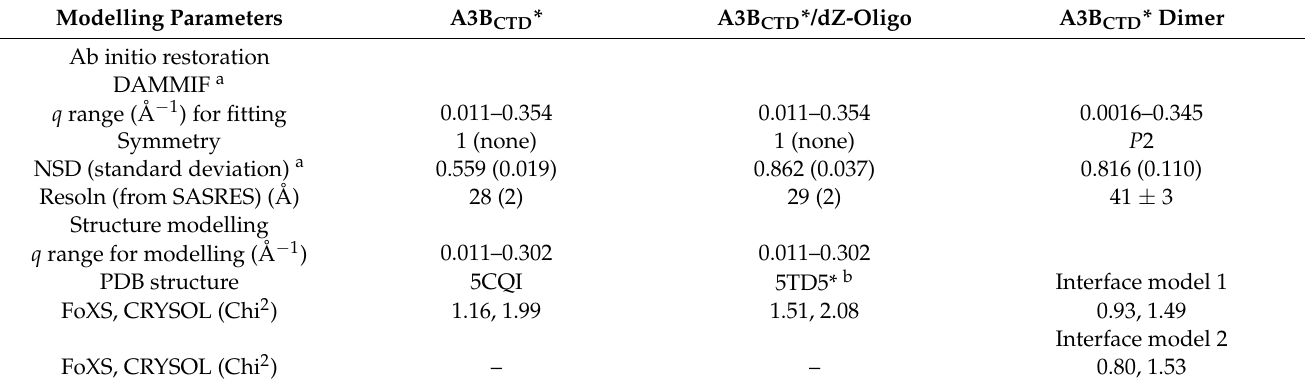
Figure 4. Fitting of experimental (exptl) A3B CTD * SAXS profiles to known A3B CTD crystal structures. ( A ) Model fit of A3B CTD * to 5CQI crystal structure. ( B ) Model fit of A3B CTD */ dZ-oligo complex (injected into SEC-FPLC in a 1:2 ratio) to 5TD5* crystal structure. ( C ) Envelope calculated from A3B CTD * SAXS data with 5CQI fitted into the envelope. ( D ) Envelope calculated from A3B CTD */dZ-oligo SAXS data with 5TD5* fitted into the envelope. Table 2. SAXS fitting and modelling parameters of the A3B CTD * and A3B CTD */dZ-oligo